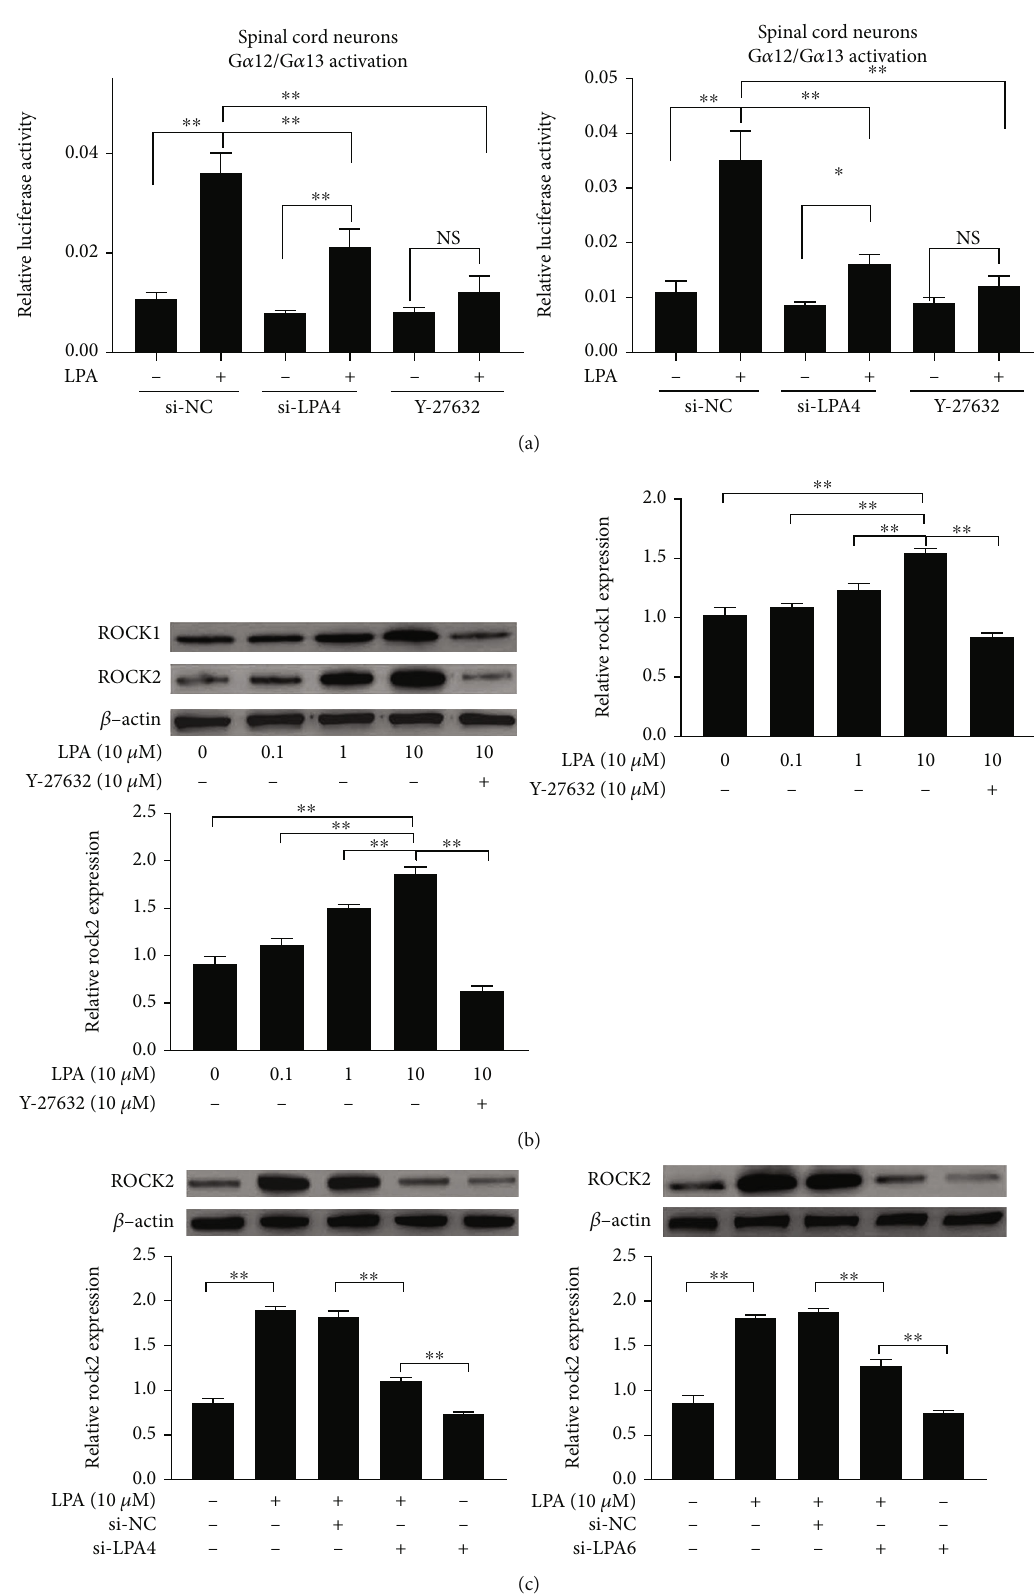
Figure 8: LPA activates G α 12/13 – Rho – ROCK2 by upregulating LPA4 and LPA6. (a) Activation of the G α 12/13 pathway is detected by the serum response factor response element (SRF-RE) luciferase reporter gene. (b, c) The expression of ROCK1 and ROCK2 in spinal cord neurons were measured by western blotting. Asterisks indicate statistical signi fi cance ( ∗ p < 0 : 05 , ∗∗ p < 0 : 01